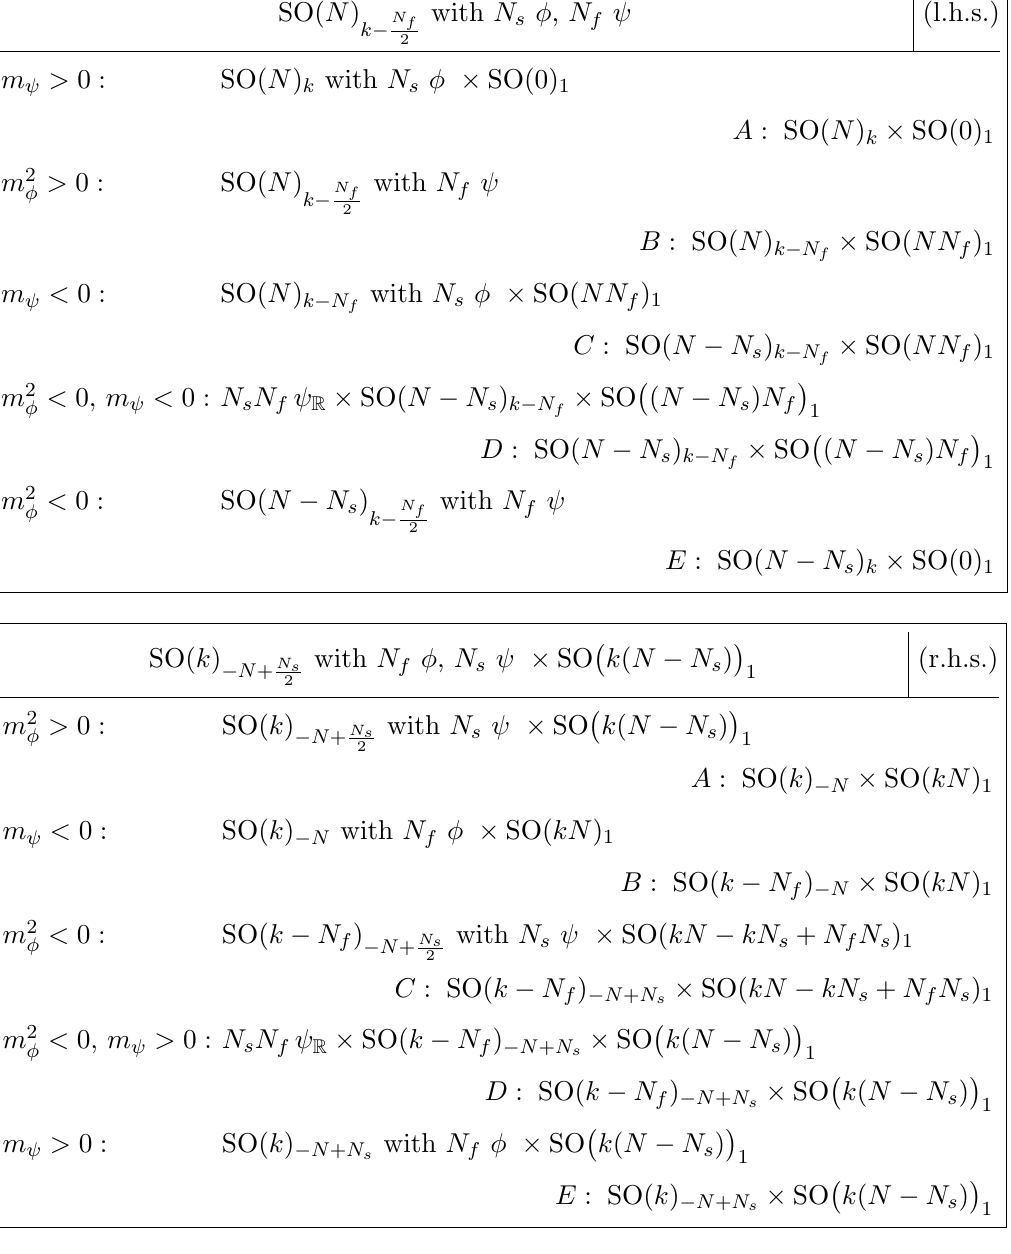
Table 5 . Phase diagram of the SO dualities. Here φ are real scalars and ψ are Majorana fermions. The validity range of the table is explained in the main